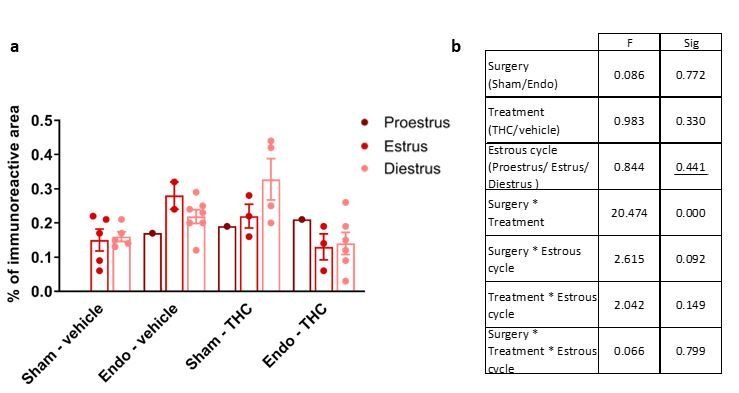
Effects of THC and stage of the estrous cycle on uterine innervation.(a) Uterine innervation (represented as% of beta-III tubulin immunoreactive area) in the different experimental groups and estrous cycle stages. (b) Significance of the effects according to a Three-way ANOVA. A significant effect of the interaction between surgery and treatment was found as shown in Figure 4B. However, no effect of the estrous cycle was detected. Error bars are mean ± SEM. Endo, endometriosis.